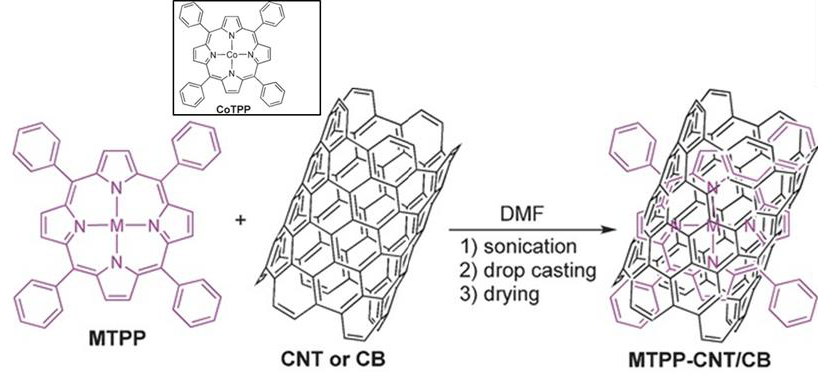
Figure 3. Immobilization of the catalyst–carbon composite on GC (M = Co or Fe-Cl). Inset: Chemical structure of CoTPP [75].